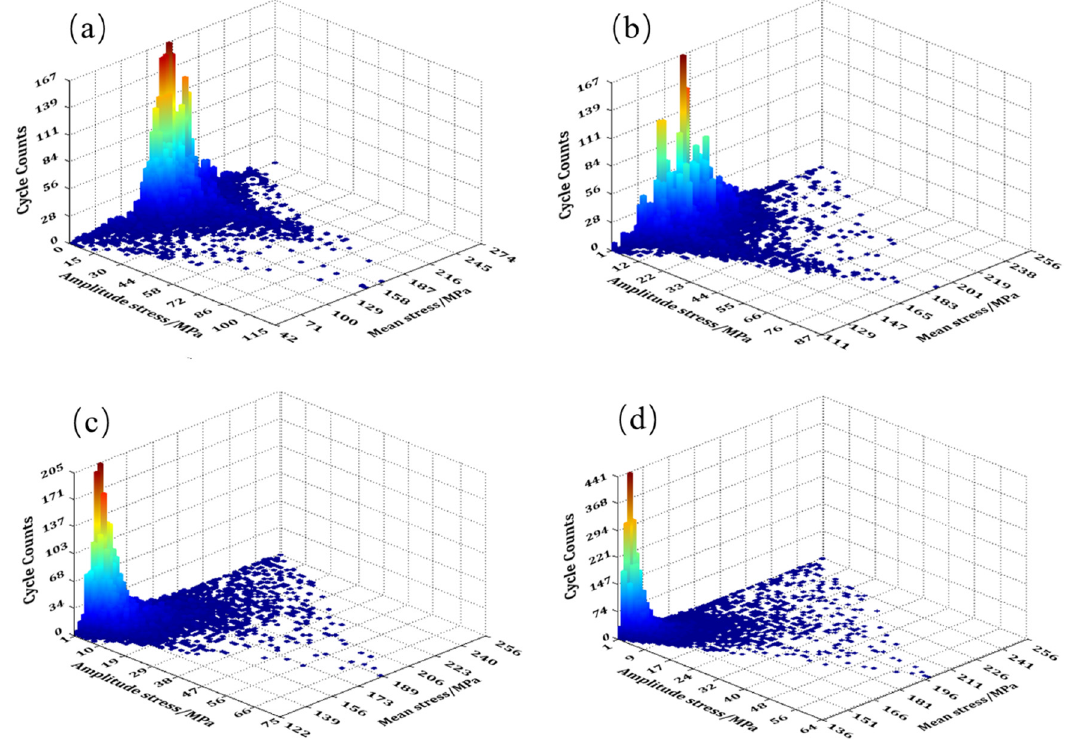
Figure 21: 2D load spectra of SVM stress in 64 grades. ( a ) Contact clamp; ( b ) messenger clamp; ( c ) support base at bottom; ( d ) bushing ears at top frame